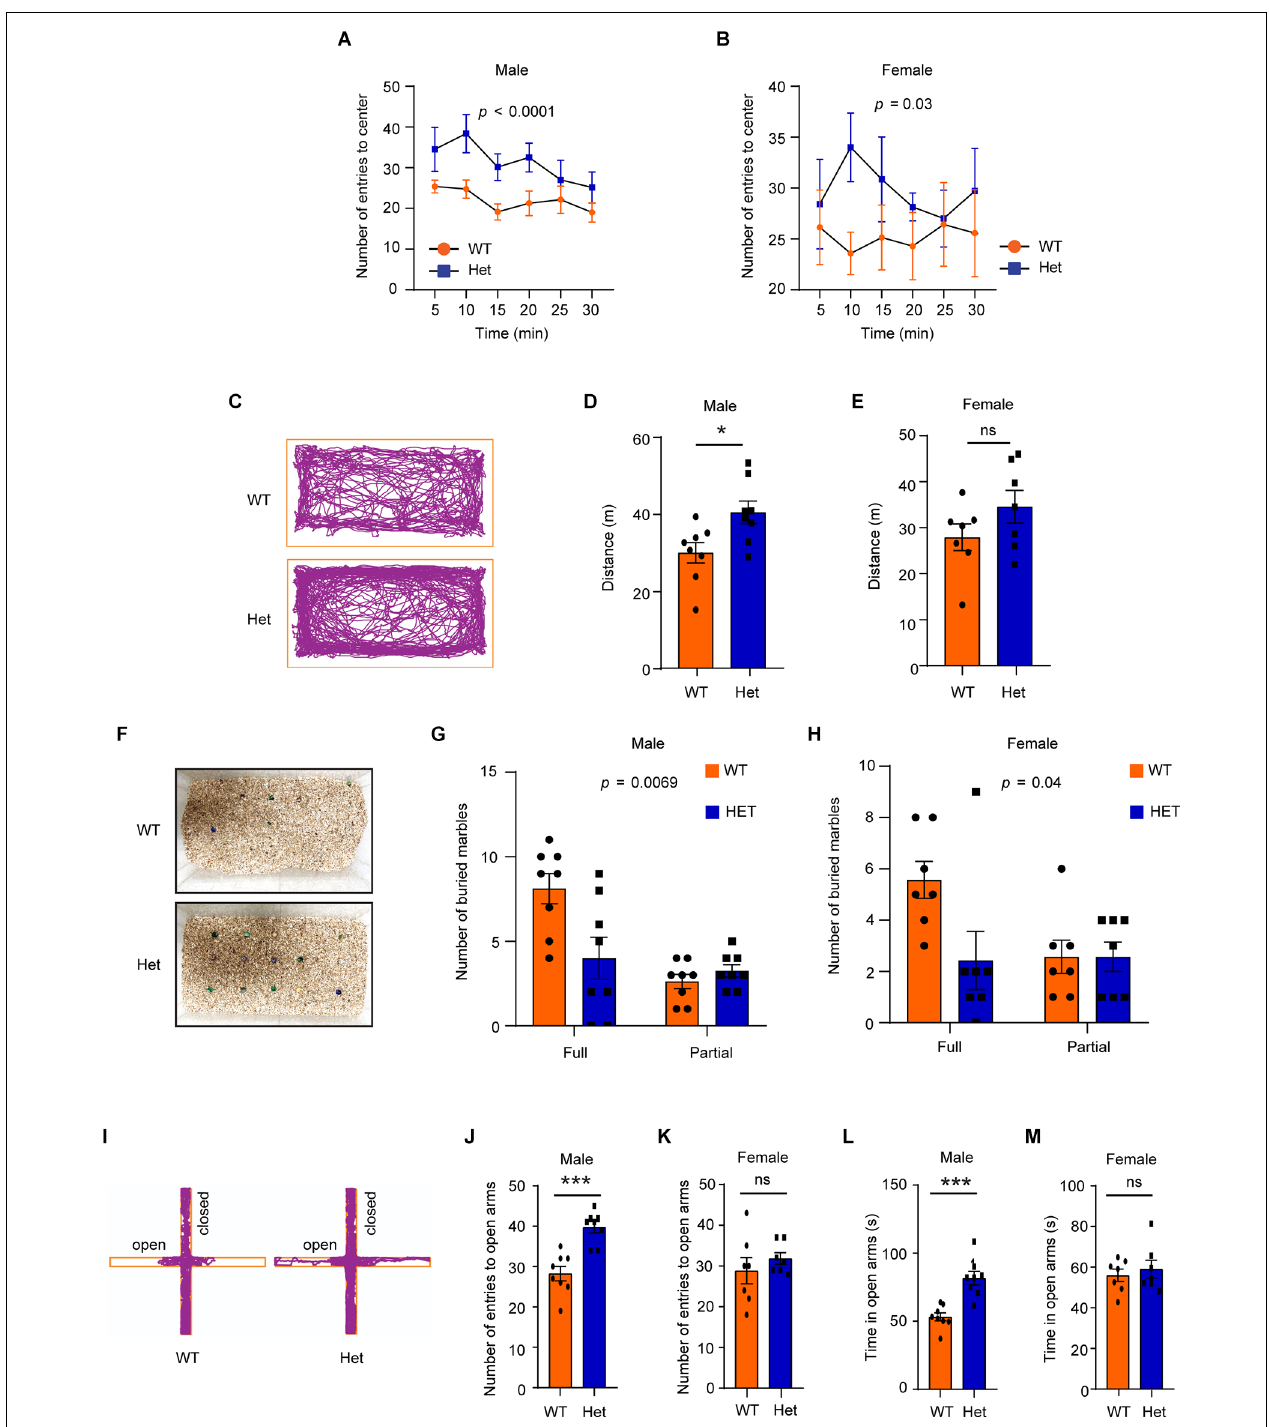
FIGURE 4 | Heterozygous Kdm6b knockout mice have reduced anxiety-like behaviors under stress. (A,B) The plots showing the number of male (A) and female (B) wild-type and heterozygous Kdm6b -KO mice entering the arena center in a 5-min period for 30 min in the open-field chamber. P-value calculated using two-way ANOVA test. The results shown are the effect of genotype on the number of mice entering the arena center (male: F 1,84 = 21.07, p < 0.0001, female: F 1,72 = 4.89, p = 0.03). Error bars in graphs represent mean ± SEM. (C) Representative traces of wild-type and heterozygote Kdm6b -KO mice in the marble burying testing cages. (D,E) The bars showing the running distances of male (D) and female (E) wild-type and heterozygous Kdm6b -KO mice in the marble burying testing cages. n = 8 males and 7 females per genotype. P-values calculated using a two-tailed t -test. * p < 0.01; ns: not significant. Error bars in graphs represent mean ±